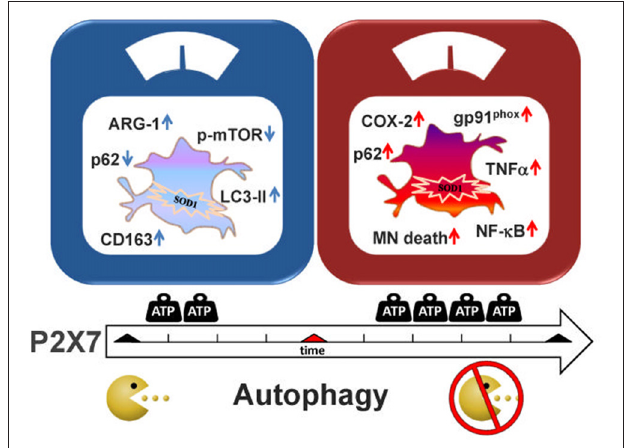
FIGURE 6 | Schematic representation of P2X7 actions in SOD1-G93A microglia. Treatment of SOD1-G93A primary microglia with P2X7 agonists BzATP or ATP modulates inflammatory and autophagic markers. After a short stimulation (left panel), P2X7 induces an increase in M2 markers (ARG-1 and CD163) concomitantly with the stimulation of the autophagic process by augmenting LC3-II and decreasing p62 and p-MTOR levels. Conversely, a sustained activation with P2X7 agonists (right panel), causes inhibition of the autophagic flux with up-regulation of p62 that is parallel to previous results showing an increase of pro-inflammatory M1 markers gp91 phox (Apolloni et al., 2016b), cyclooxygenase-2 (COX-2; D’Ambrosi et al., 2009), and moreover nuclear factor kappa-B (NF- κ B; Parisi et al., 2016), tumor necrosis factor alpha (TNF- α ) and motor neurons (MN) death (D’Ambrosi et al.,